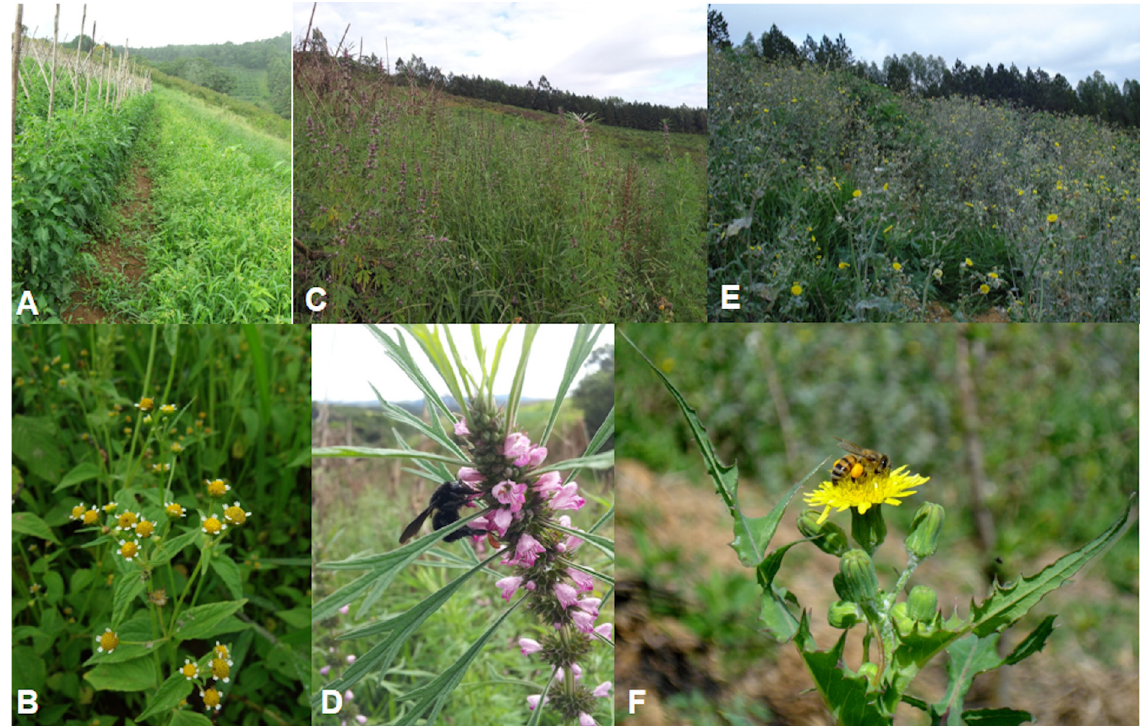
Fig 4 . Ruderal plant growth sites at the studied smallholder rural properties. A: Ruderal plant strip, with a dominance of the species Galinsoga parviflora , next to tomato crop. B: Galinsoga parviflora . C: post-harvest site dominated by specimens of the ruderal plant Leonurus sibiricus . D: Bombus bee on Leonurus sibiricus inflorescence. E: post-harvest site dominated by specimens of the ruderal plant Sonchus oleraceus . F: Apis mellifera bee on Sonchus oleraceus